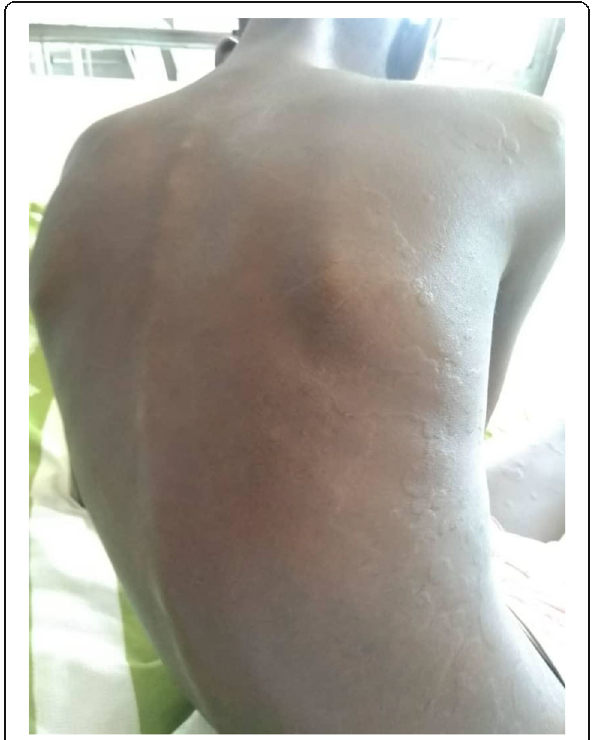
Fig. 3 Skin eruptions on the trunk showing macules, plaques and patches with pale centres and raised borders